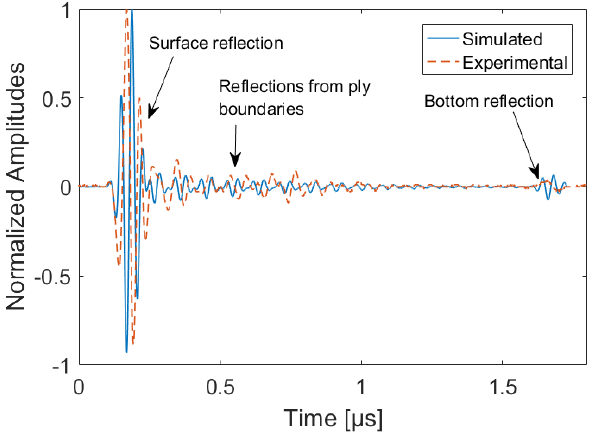
Figure 6. Simulated and experimental signals of a non-defective CFRP structure.